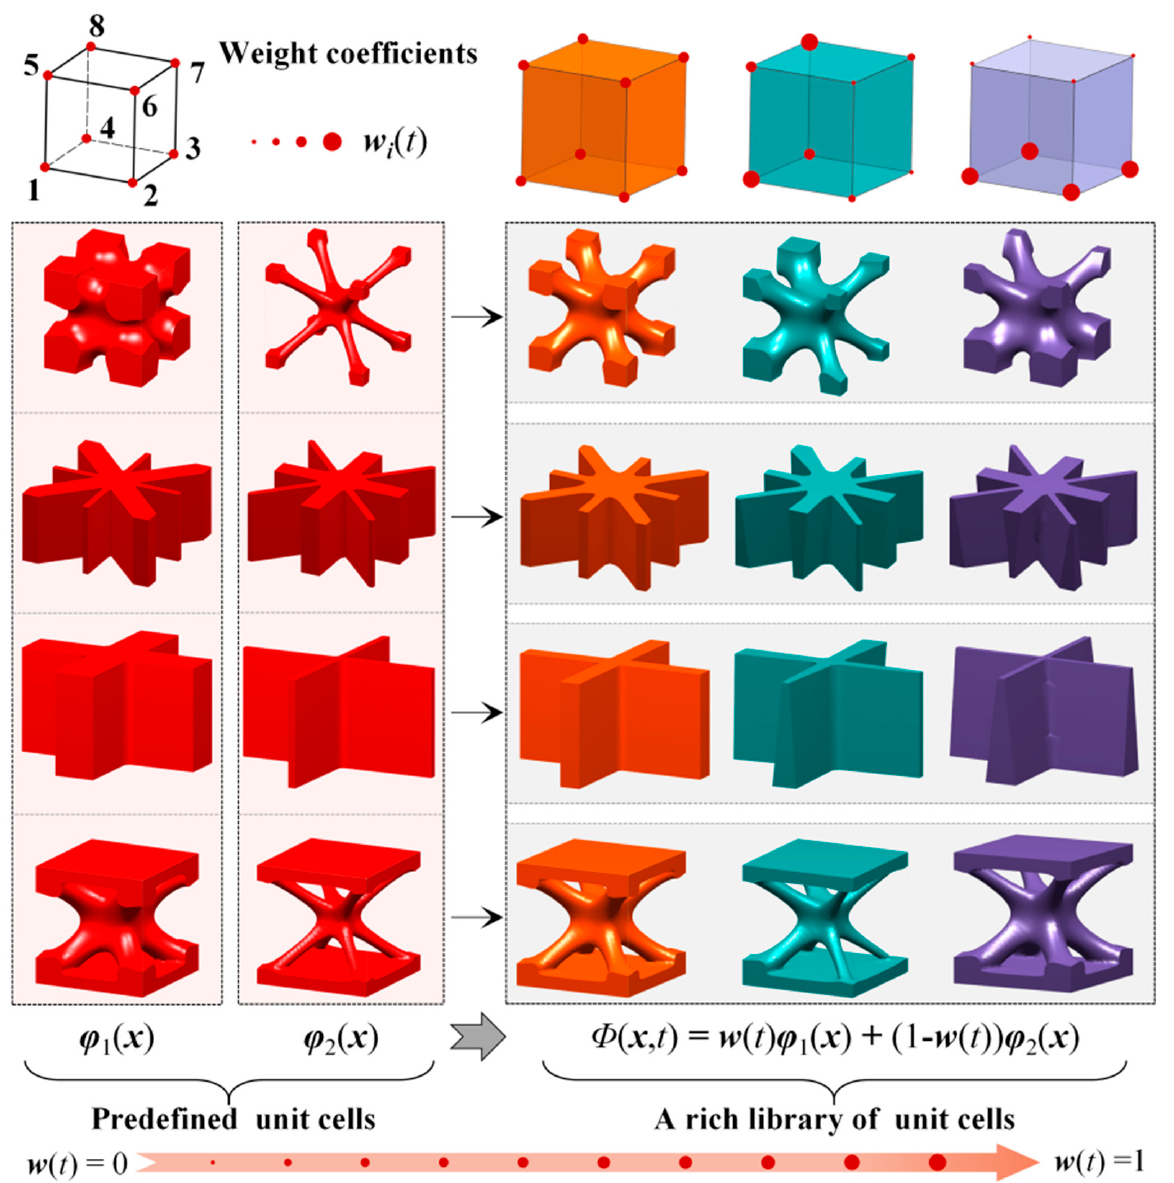
Figure 4. Illustration of FGSs unit cells generated with the HLSF.